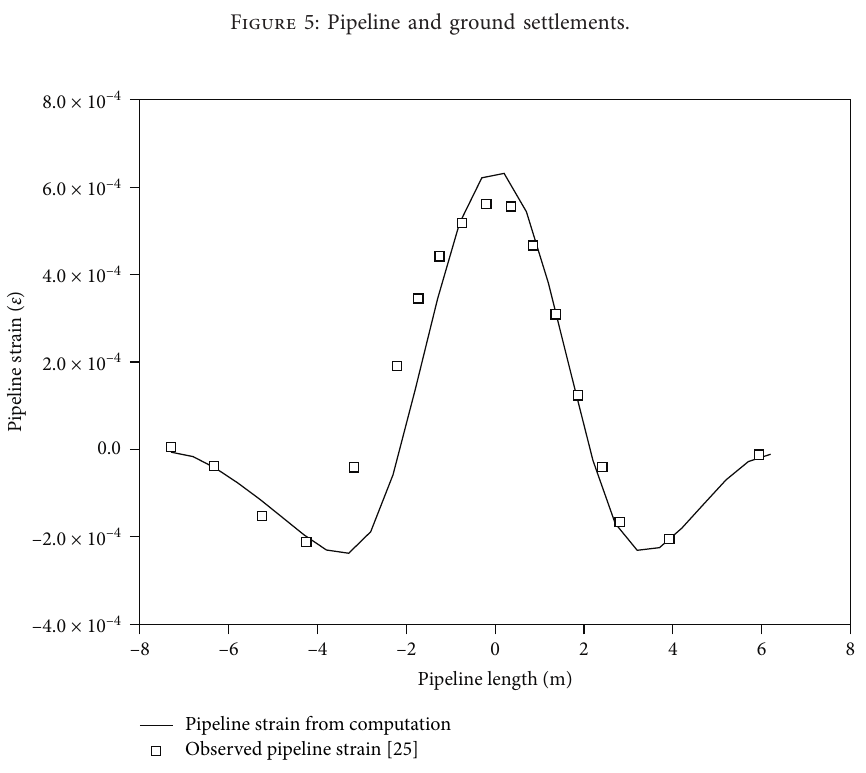
Figure 6: Comparison of the pipeline bending